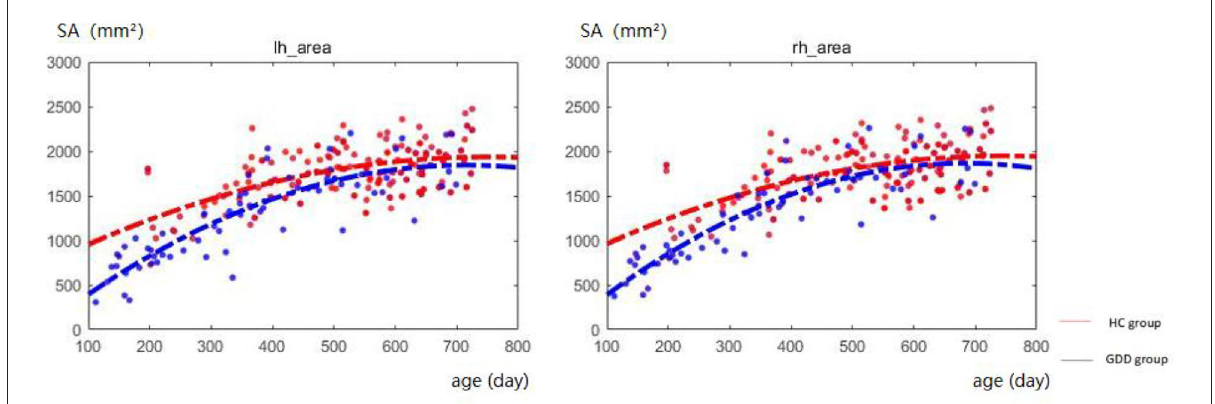
FIGURE3 Hemispherical SA developmental trajectory between the two groups. The red line represents the HC group, and the blue line represents the GDD group (lh, left hemisphere; rh, right hemisphere).